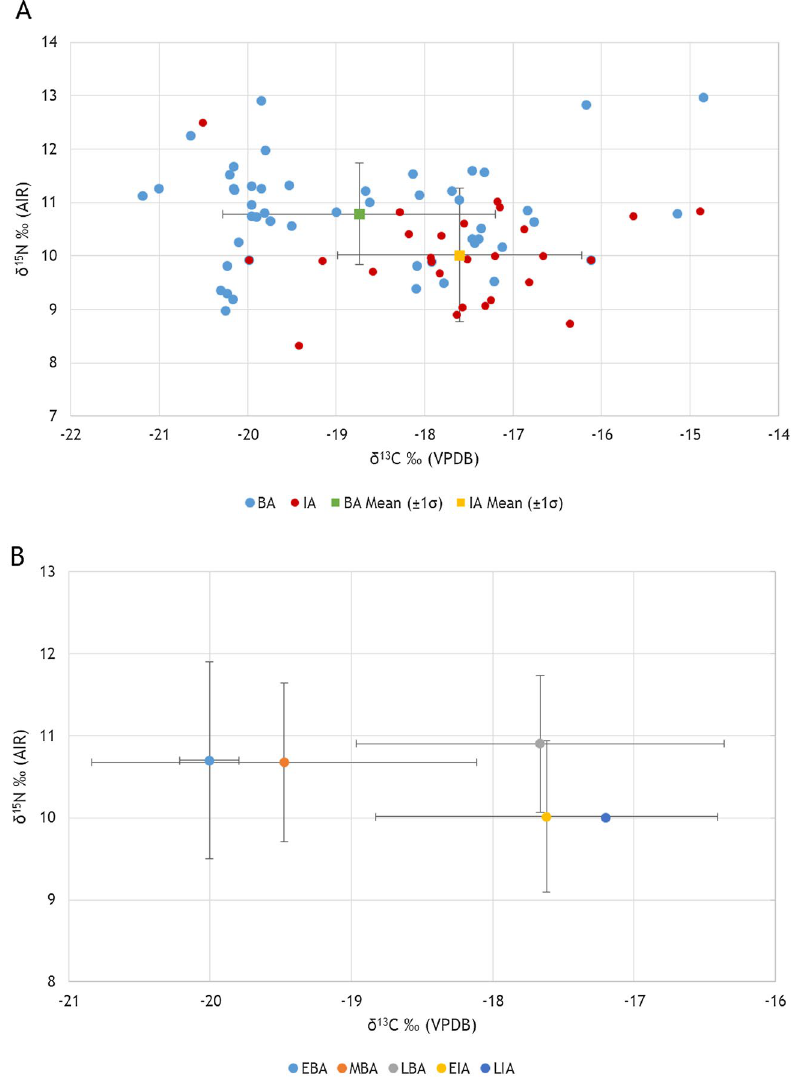
Figure 2. Scatterplots of human δ 13 C and δ 15 N ratios with mean δ 13 C and δ 15 N ratios (± 1 σ) by period ( A ) Bronze Age/BA (n = 50) and Iron Age/IA (n = 24) and subperiod ( B ) Early Bronze Age/EBA (n = 8), Middle Bronze Age/MBA (n = 18), Late Bronze Age/LBA (n = 22), and Early Iron Age/EIA (n = 24).